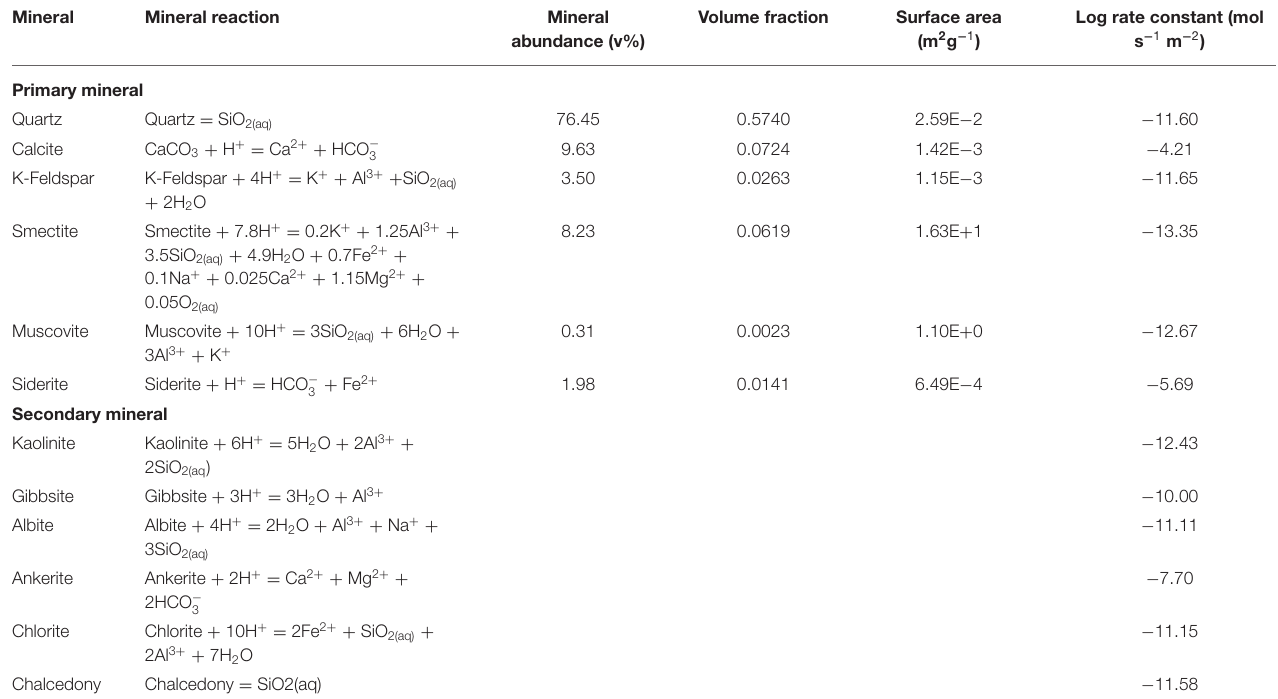
TABLE 1 | Mineral abundance as percent volume, volume fraction, and surface area of the Paluxy formation obtained from multi-scale imaging of the sample in Qin and Beckingham (2019) and rate constants for the respective mineral phases at reservoir condition as obtained from the literature for quartz (Knauss and Wolery, 1988; Brady and Walther, 1990), calcite (Alkattan et al., 1998), K-Feldspar (Bevan and Savage, 1989), Smectite (Amram and Ganor, 2005), Muscovite (Oelkers et al., 2008), and Siderite (Golubev et al., 2009).